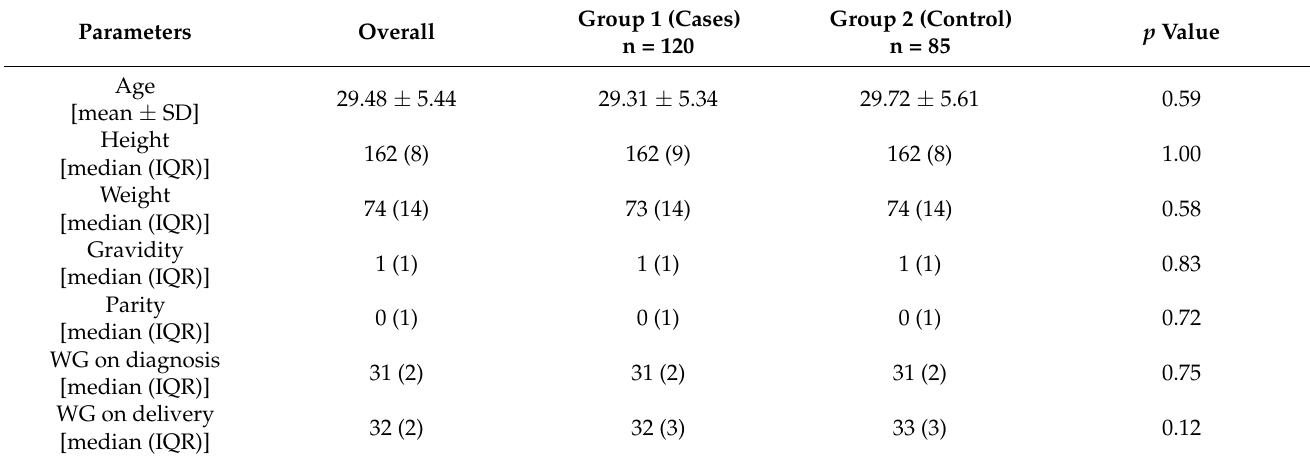
Table 1. Characteristics of 205 participants with early onset FGR.